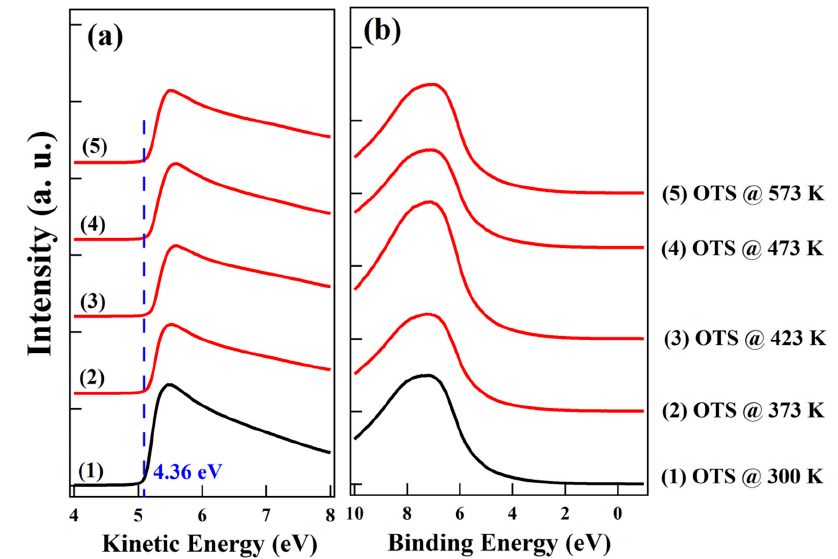
Figure 2. Spectra at the ( a ) secondary electron cut-o ff and ( b ) valence band region for OTS as a function Figure 2 . Spectra at the ( a ) secondary electron cut-off and ( b ) valence band region for OTS as a of vacuum annealing function of vacuum annealing temperature.